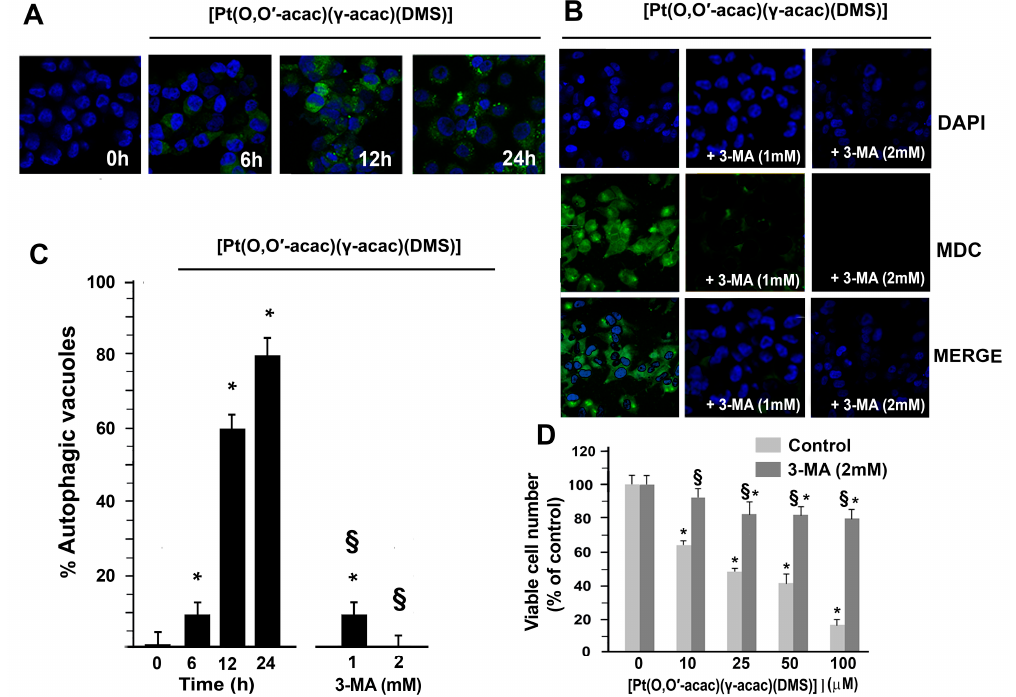
Figure 3. [Pt( O , O (cid:48) -acac)( γ -acac)(DMS)] induces autophagy in Caki-1 cells. ( A ) Caki-1 cells were treated with 10 µ M [Pt( O , O (cid:48) -acac)( γ -acac)(DMS)] for the indicated times or ( B ) Caki-1 cells were pretreated, or not, with 1 mM of 3-MA or 2 mM of 3-MA, then treated with 10 µ M [Pt( O , O (cid:48) -acac)( γ -acac)(DMS)] for 24 h; subsequently, Caki-1 cells were stained with monodansylcadaverine (MDC) and 4 (cid:48) ,6-diamidino-2-phenylindole (DAPI). The cellular fluorescent changes were observed through confocal microscopy Zeiss LSM 700 (Carl Zeiss AG, Oberkochen, Germany). ( C ) Quantification of the percentage of autophagic vacuoles are presented as means ± SD. * p < 0.001 between treated and untreated cells; § p < 0.001 between cells treated with 3-MA and [Pt( O , O (cid:48) -acac)( γ -acac)(DMS)], and cells treated with [Pt( O , O (cid:48) -acac)( γ -acac)(DMS)] alone, by Student’s t -test ( n = 5). ( D ) Caki-1 cells were treated with increasing concentrations of [Pt( O , O (cid:48) -acac)( γ -acac)(DMS)] and 2 mM of 3-MA for 24 h, and cell viability was monitored by MTT assay. * p < 0.001 between treated and untreated cells, by Student’s t -test ( n = 5). § p < 0.001 between cells treated with SP600125 and [Pt( O , O (cid:48) -acac)( γ -acac)(DMS)], and cells treated with [Pt( O , O (cid:48) -acac)( γ -acac)(DMS)] alone; § p < 0.001 between cells treated with 3-MA and [Pt( O , O (cid:48) -acac)( γ -acac)(DMS)], and cells treated with [Pt( O , O (cid:48) -acac)( γ -acac)(DMS)] alone, by Student’s t -test ( n =